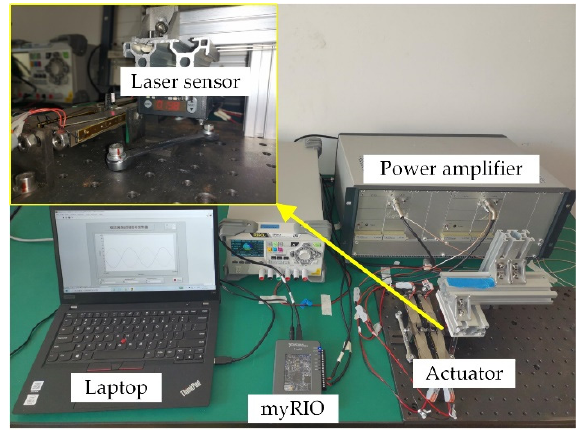
Figure 10. Bench-top test of the actuator prototype.